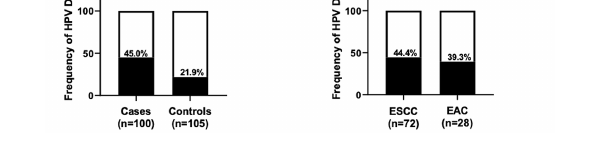
FIGURE 1 Frequency of HPV DNA in EC tissue samples. The column graph demonstrated the frequency of HPV DNA detected by the HPV Direct Flow CHIP technique in the FFPE specimens collected from EC cases and control subjects (A) . The infection rate of HPV in different histology subtypes of EC was also illustrated (B)